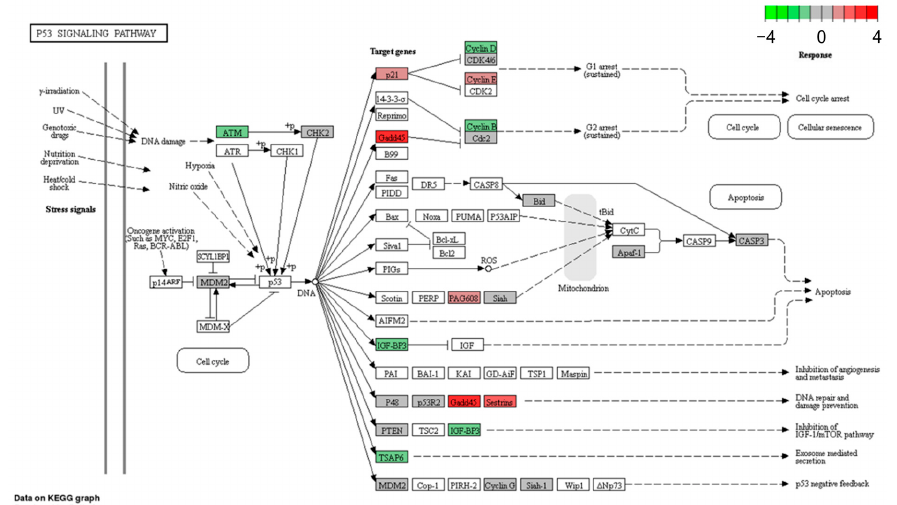
Figure 3. BA-induced p53 KEGG pathway in MDA-MB-231 cells (mtp53) under hypoxia (Benjamini- Hochberg adjusted p = 0.01). Apaf-1, apoptotic peptidase activating factor 1; ATM, ataxia telang- iectasia mutated; Bid, BH3 interacting domain death agonist; CASP3, Caspase 3; CDK4/6, cyclin- dependent kinase 4/6; Cdc2 (=CDK1), cell division cycle 2; CHK2, cell cycle checkpoint kinase; GADD45, growth arrest and DNA damage-inducible protein 45; IGFBP3, insulin-like growth factor- binding protein 3; MDM2, mouse double minute 2 homolog; PAG608 (ZMAT3), p53-activated gene 608 protein; PTEN, phosphatase and tensin homolog; p21 (=CDKN1A), cyclin-dependent kinase inhibitor 1A; p48 (=PTF1A), pancreas associated transcription factor 1a; p53R2 (=RRM2B), ribonu- cleotide reductase regulatory TP53 inducible subunit M2B); SESN2, sestrin-2; Siah-1, seven in absentia homolog 1; TSAP6 (=STEAP3), tumor suppressor-activated pathway protein